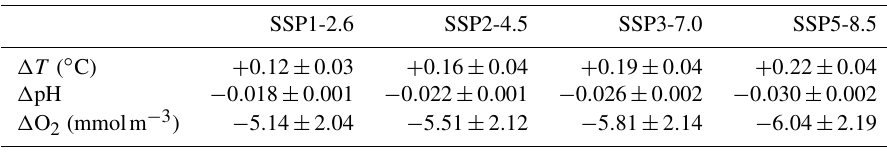
Table 5. Global mean projected changes in benthic ocean impact drivers in CMIP6. Global mean anomalies of bottom-water temperature ( ◦ C), pH, and dissolved O 2 concentration for the CMIP6 SSPs. Anomalies are 2080–2099 mean values relative to the 1870–1899 baseline period. Uncertainty estimates are the inter-model SD.